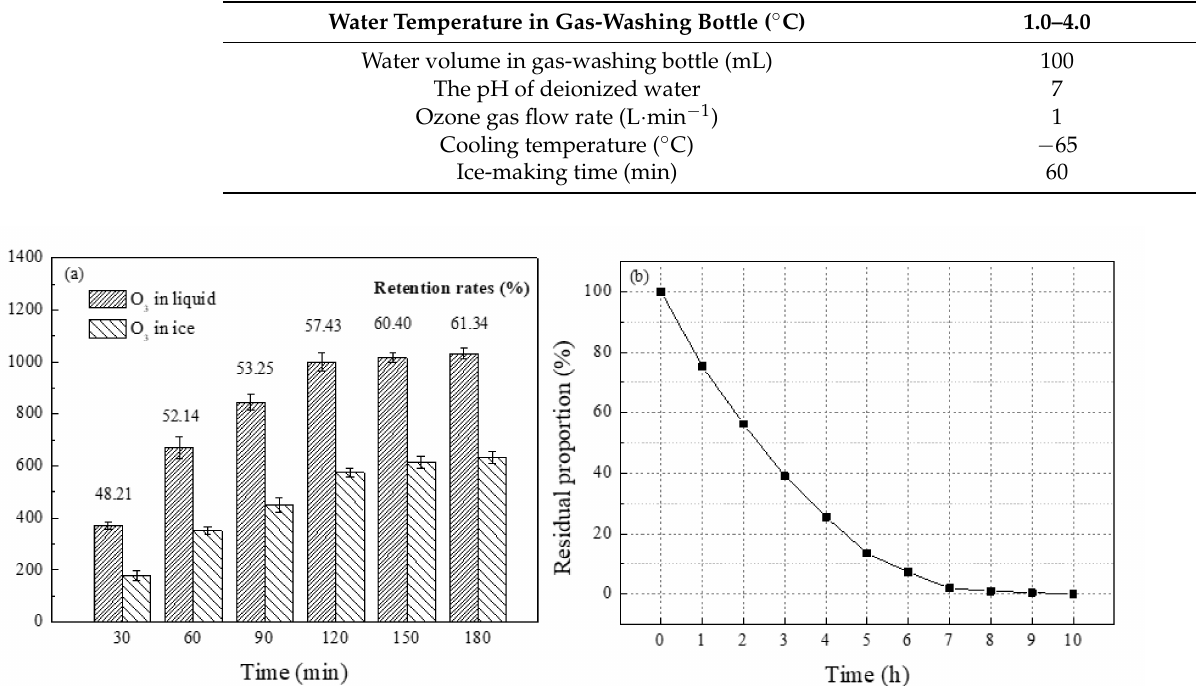
Figure 4. ( a ) Relationship between ventilation time and ozone concentration. ( b ) Relationship between ice residual proportion and time at 5 ◦